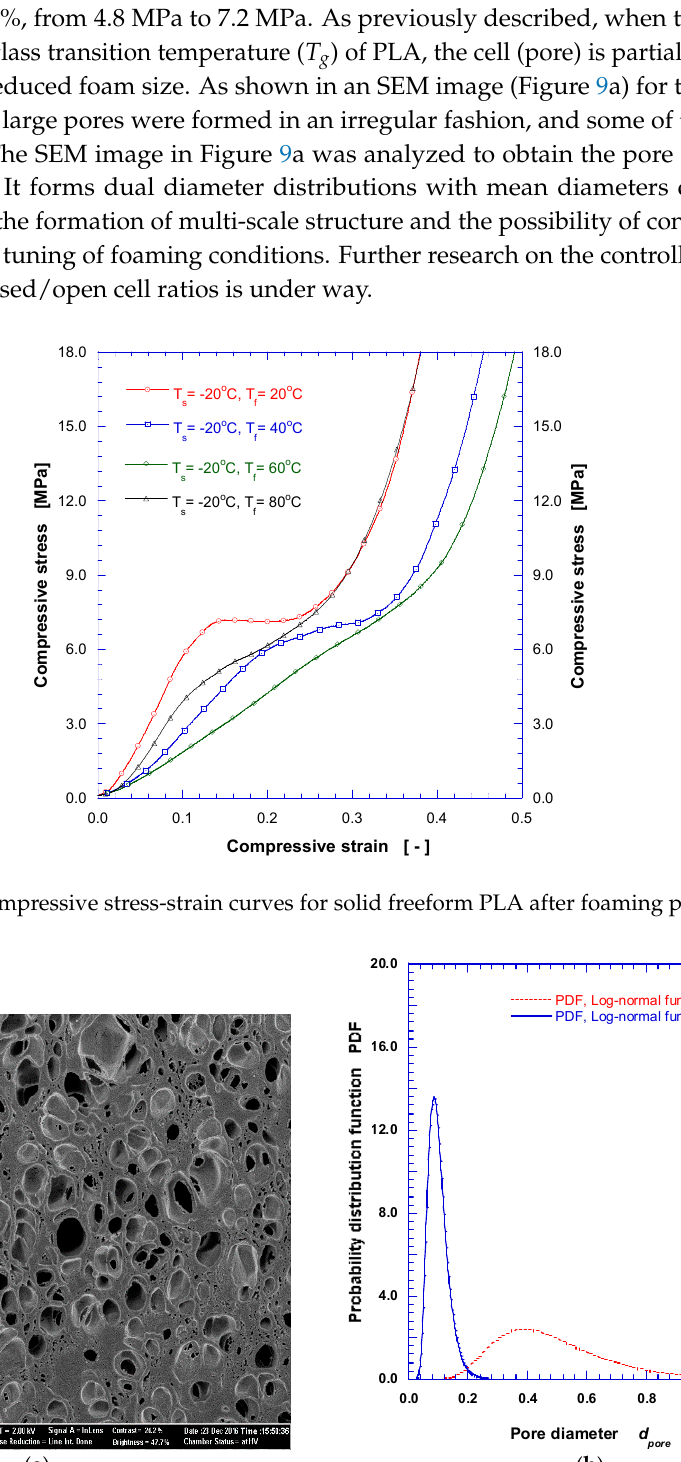
Figure 9. SEM image ( a ); and size distribution ( b ) of multiscale pores in nano-cellular PLA rib prepared at 𝑇 𝑠 = − 20 °C and 𝑇 𝑓 = 80 °C .